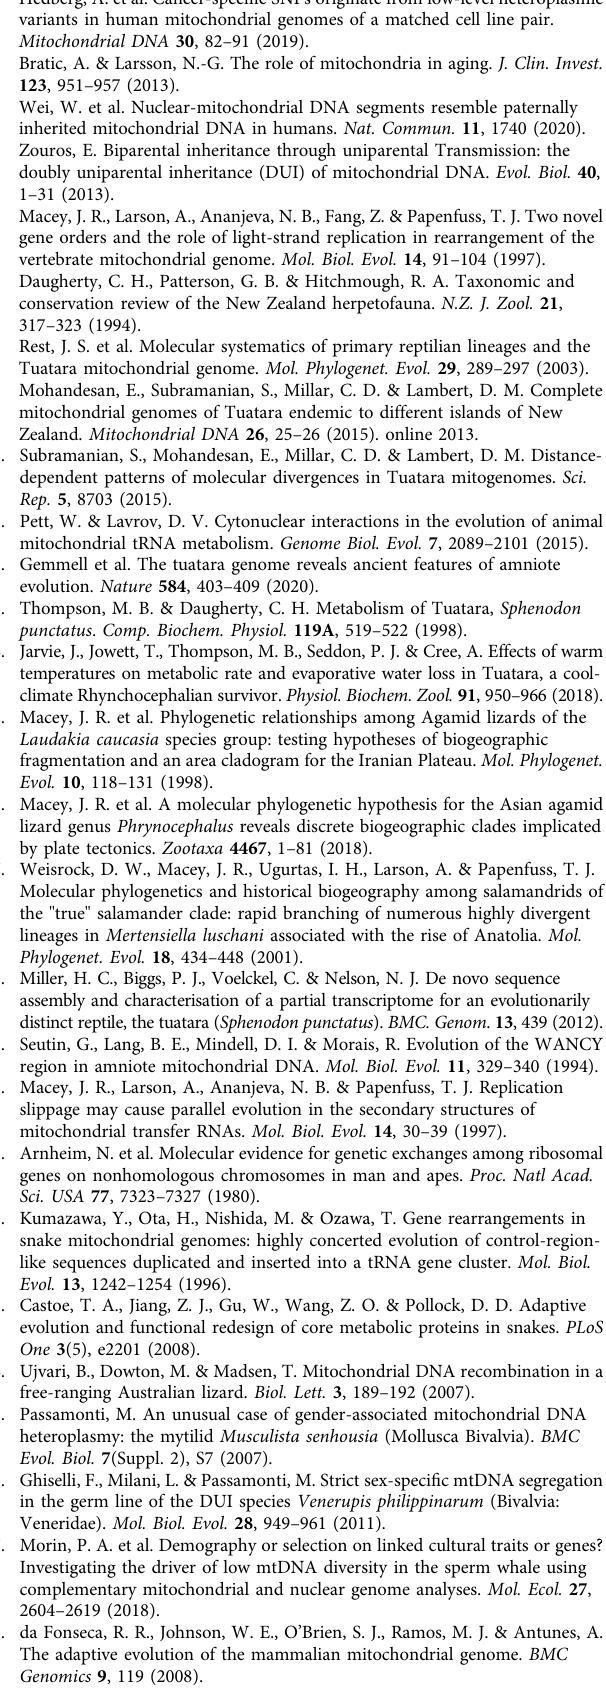
(Supplementary Table 1) using ETE3 46 and to FEL 47 using HyPhy 48 to detect selective pressures on individual sites of the LAI M2 lineage. For ND5, the only available LAI M1 & M2, SI-3, and SI-4 sequences were used. Within PAML, we used Bayes Empirical Bayes (BEB) 49 with a threshold of P> 95% as evidence for protein structure visualization, ConSurf Server 51,52 uses HMMER to search for homologs in the UNIREF-90 database (E-value cut-off of 0.0001), and 150 sampled protein sequences (min/max identity of 35%/95%) are aligned using MAFFT-L- INS-i. HHPred and MODELER then apply the best evolutionary substitution model (JTT) to predict the 3D structure of proteins 52 . The structures are visualized using PyMOL 53 (see Supplementary Method 7 and Supplementary Tables 1 – 3). Statistics and reproducibility . Phylogenetic statistical analyses are described in Methods. Mt-genome coverage statistics (e.g., average, min/max, depth) were calculated in Geneious. Protein evaluation statistical analyses used Python (http:// www.python.org), applying multiple tests library for multiple testing